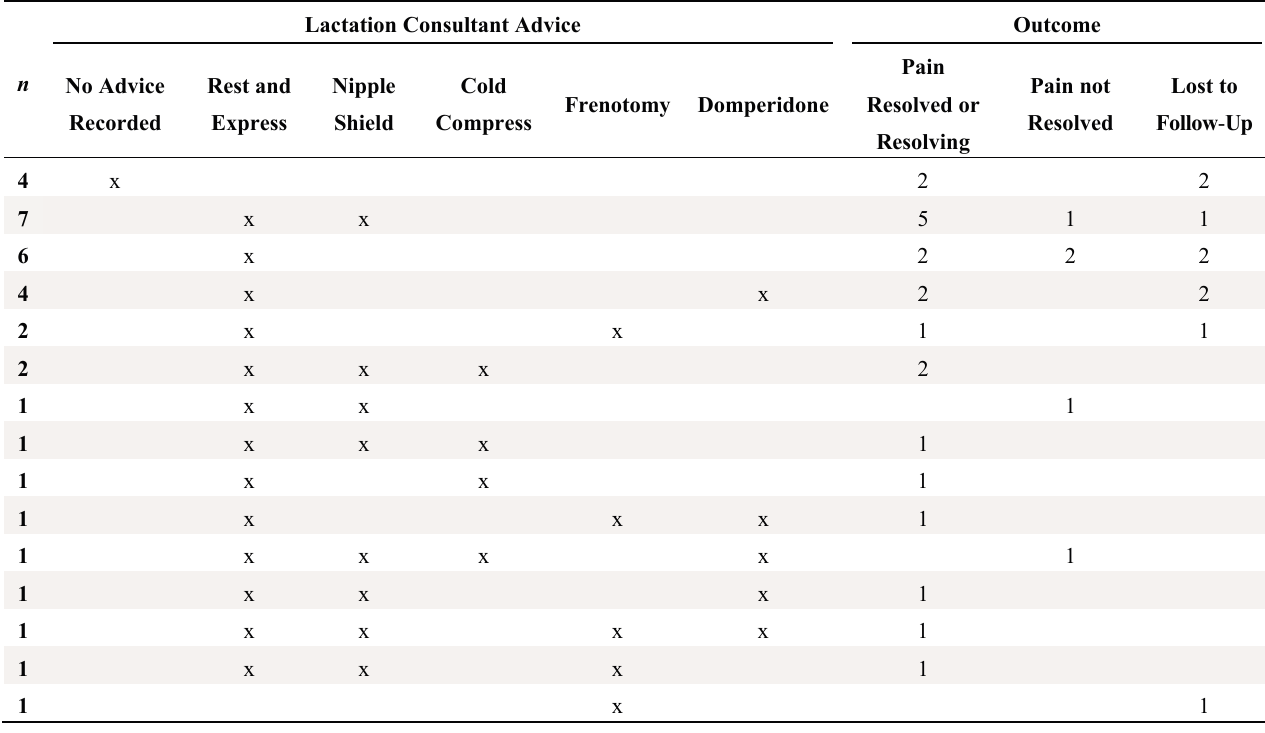
Table 1. Advice and resolution of pain when infection was suspected but cultures did not grow pathogenic organisms ( n =